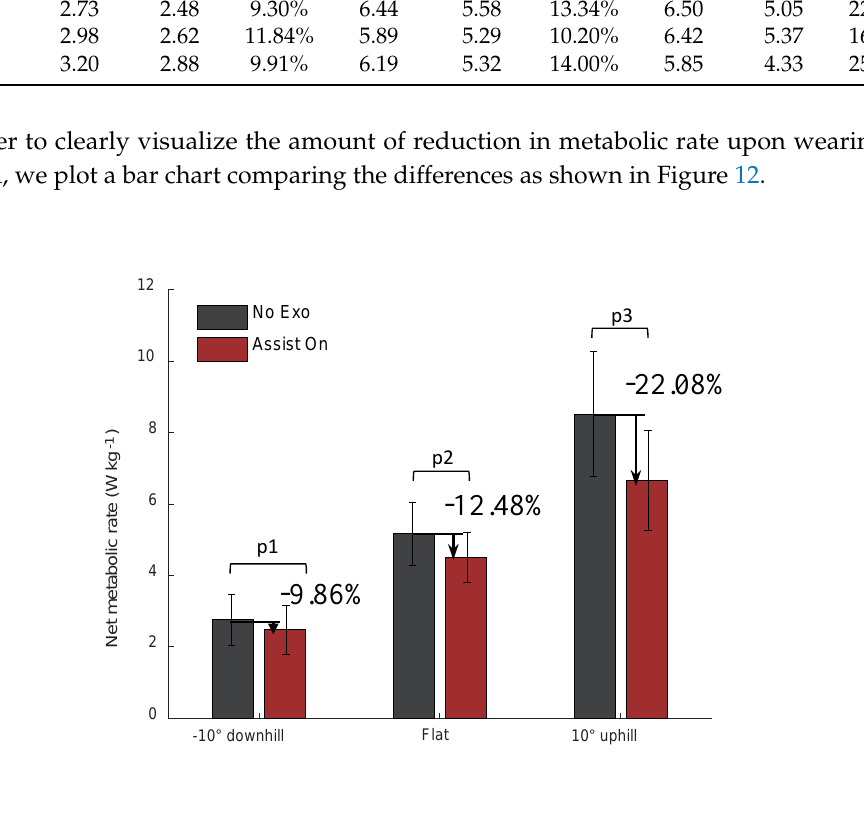
Figure 12. Metabolic rate from the average of three participant experiments for combined different terrains comparison between wearing the soft exoskeleton for assistance (Assist On) and not wearing it (No Exo). p1, p2, and p3 are the results of two-sided t-tests, which are 0.047, 0.051, and 0.038,